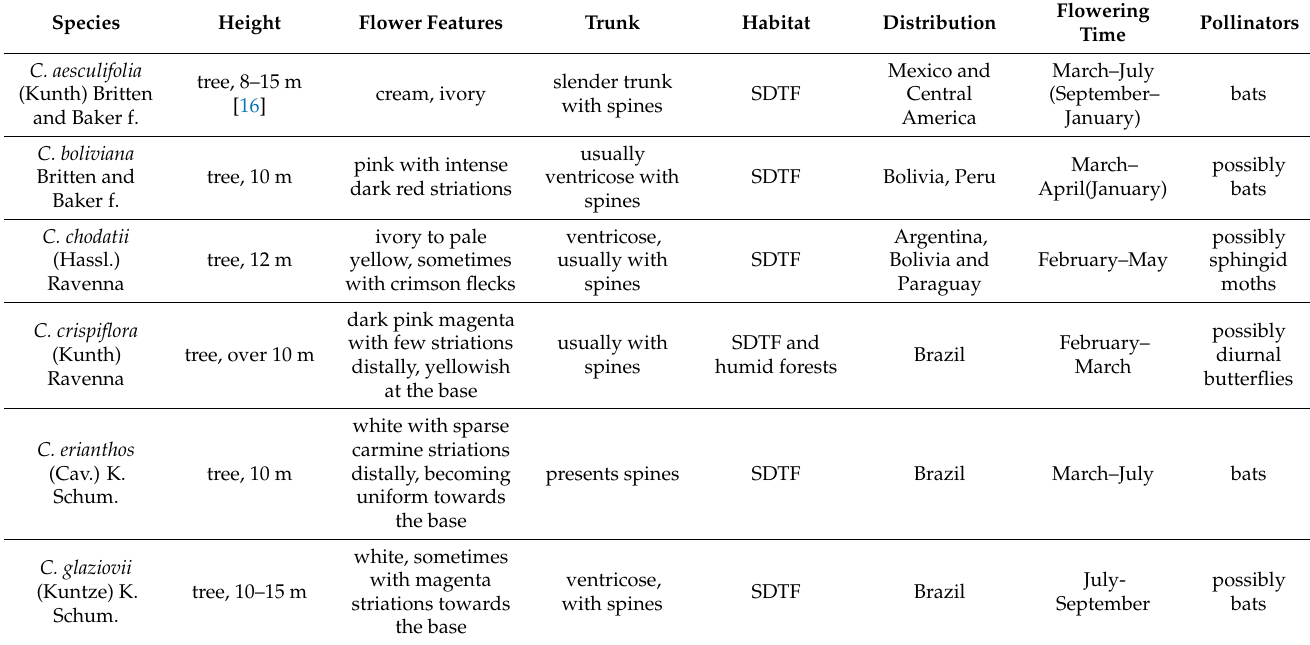
Table 1. Morphological characteristics, distribution and phenology of the 18 recognized species by [14,15]. Descriptions have been obtained from the aforementioned authors; information obtained from other sources is indicated in brackets. SDTF: seasonally dry tropical